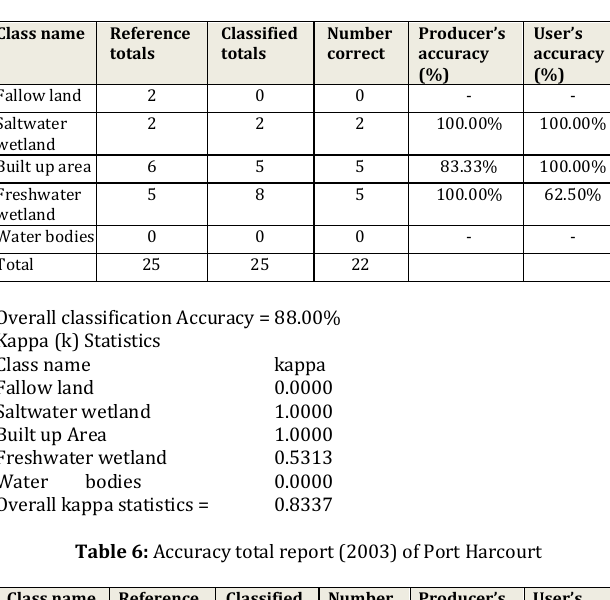
Table 5: Accuracy total report (1999) of Port Harcourt